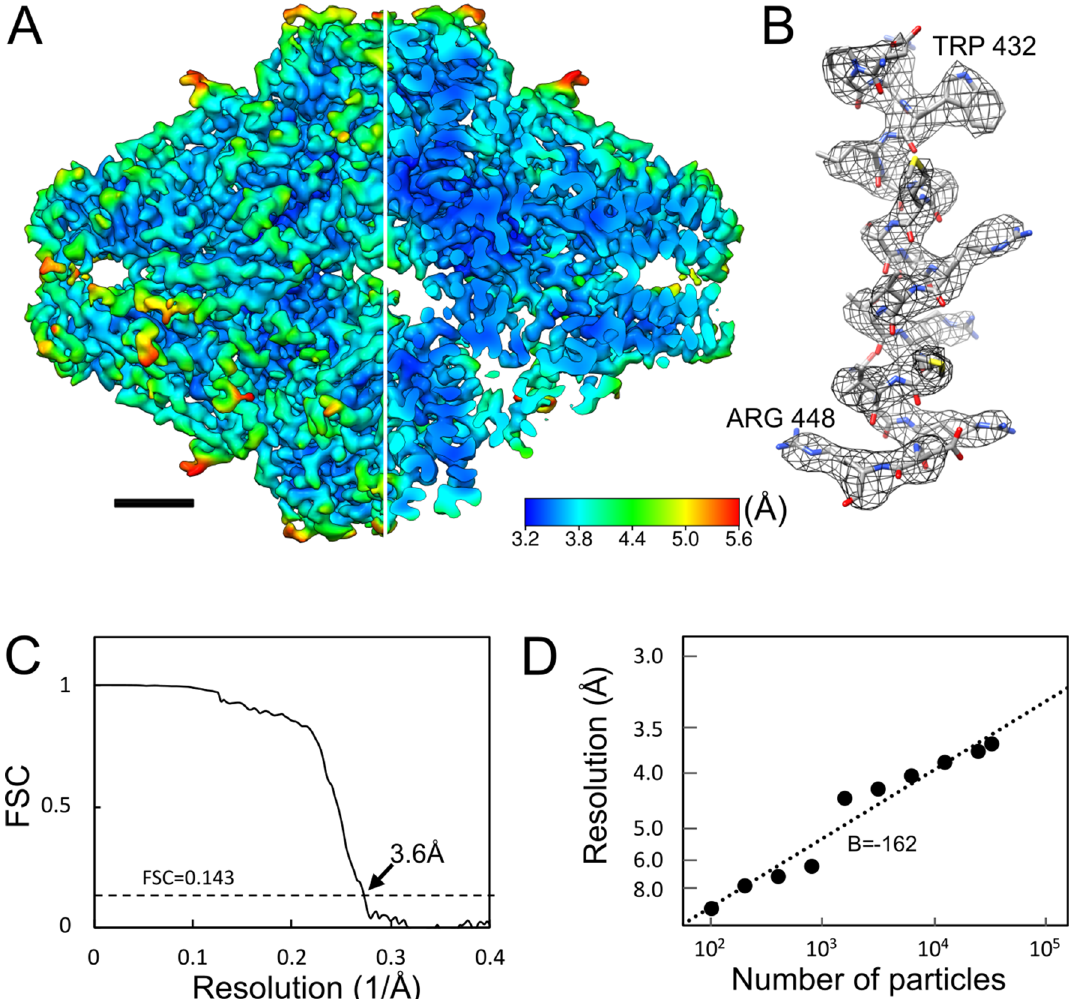
Figure 8. β-galactosidase reconstruction from Setting A using SerialEM automation software. Data was acquired in the same period (6 h) as other datasets, except via automation rather than manual operation. ( A ) 3.6 Å (global estimated resolution) reconstruction coloured by local resolution; one quarter sliced away to allow visualisation of internal density. Map is contoured at 5σ. ( B ) Representative helix (residues Asp429-Arg448) showing side-chain clarity. ( C ) GS-FSC curve. ( D ) Rosenthal-Henderson plot, estimating B-factor. Estimated B-factor is dependent on whether extremely low-particle-count reconstructions are included, which influences the overall B-factor